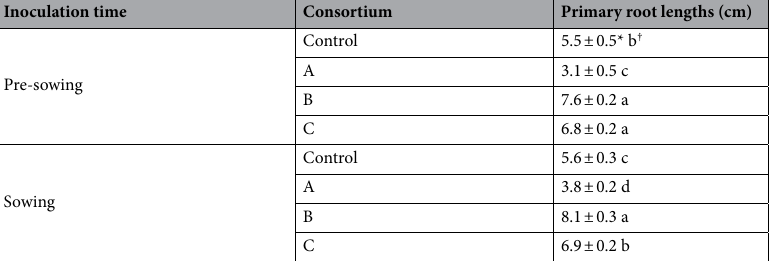
Table 4. Primary root lengths of 15-day-old tomato seedlings inoculates with formulated rhizobacterial consortia. *Values represent the means ± standard deviation of 10 seeds per treatment. † Different letter in each column denote significant differences ( P ≤ 0.05) by ANOVA followed by Tukey’s post-hoc